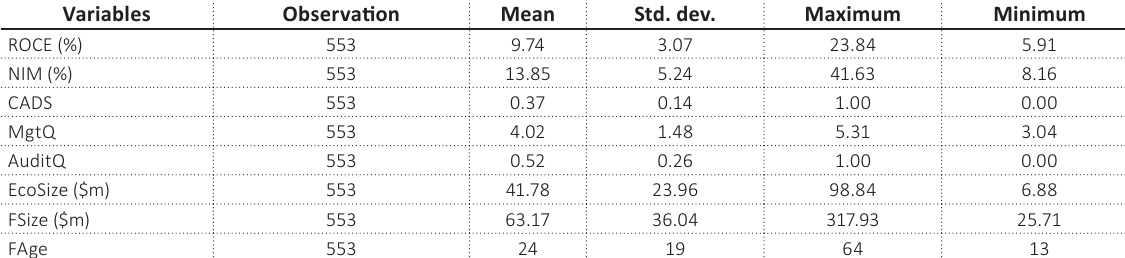
Table 1. Summary